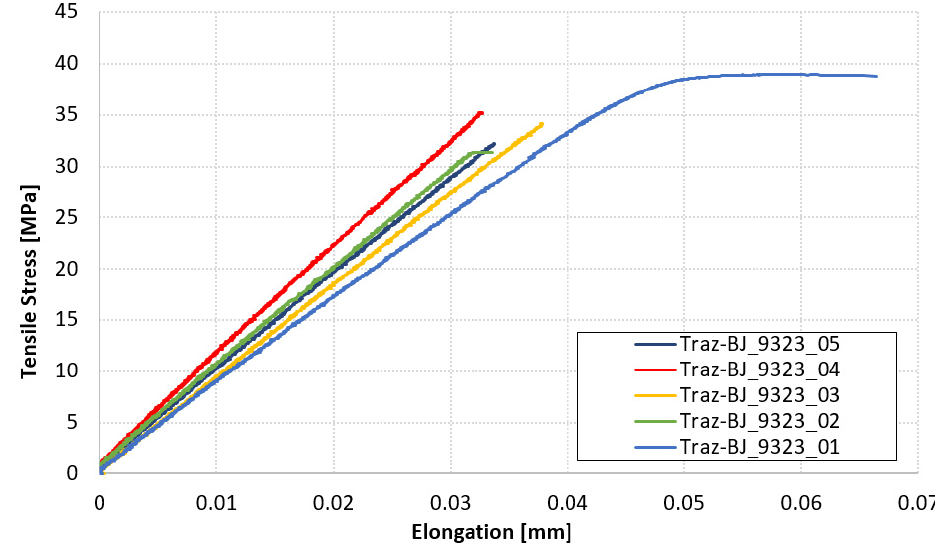
Figure 12. Force-displacement results of TRAZ-BJ_9323 tests. Table 6. Failure location and tensile strength of TRAZ-BJ_9323 tests.